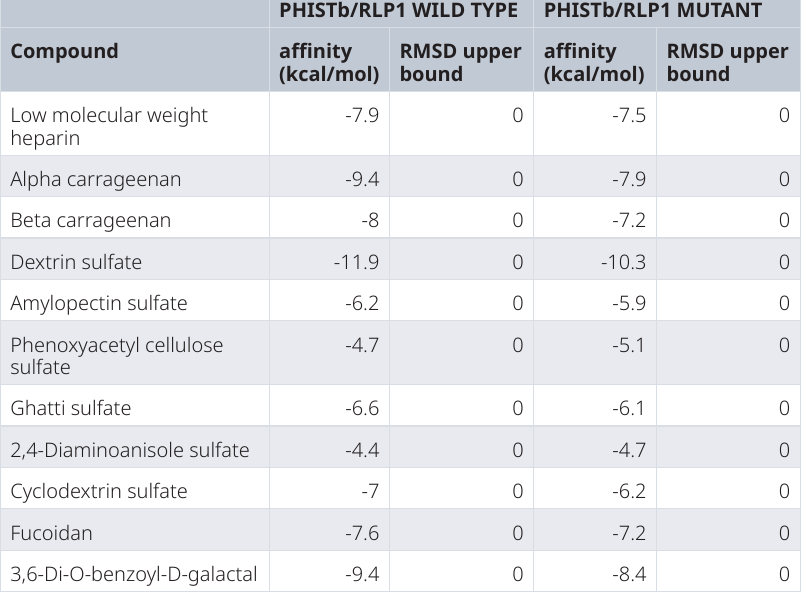
Table 10. Docking energies of each drug compound on interacting with PHISTb/ RLP1 reference and mutant proteins. The energies released were all very low, supporting the activity of the sulfated polysaccharides as drug compounds against the exported proteins. The low binding energies show high binding affinities. Generally, the docking energies in PHISTb/RLP1 mutant protein was slightly higher that in reference protein. As seen in the interaction results, the compounds are interacting with different residues in the two proteins hence the difference in the released